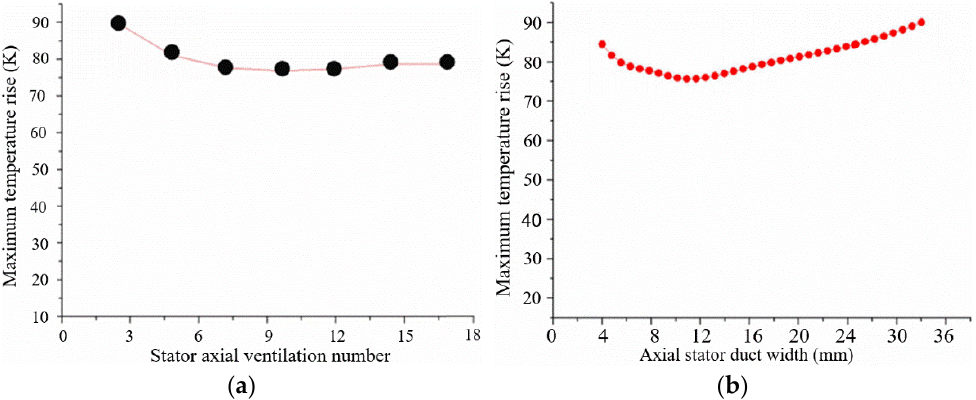
Figure 12. The correlation between slot winding maximum temperature rise with ( a ) stator axial ventilation duct number. ( b ) Duct width. ventilation duct number. ( b ) Duct